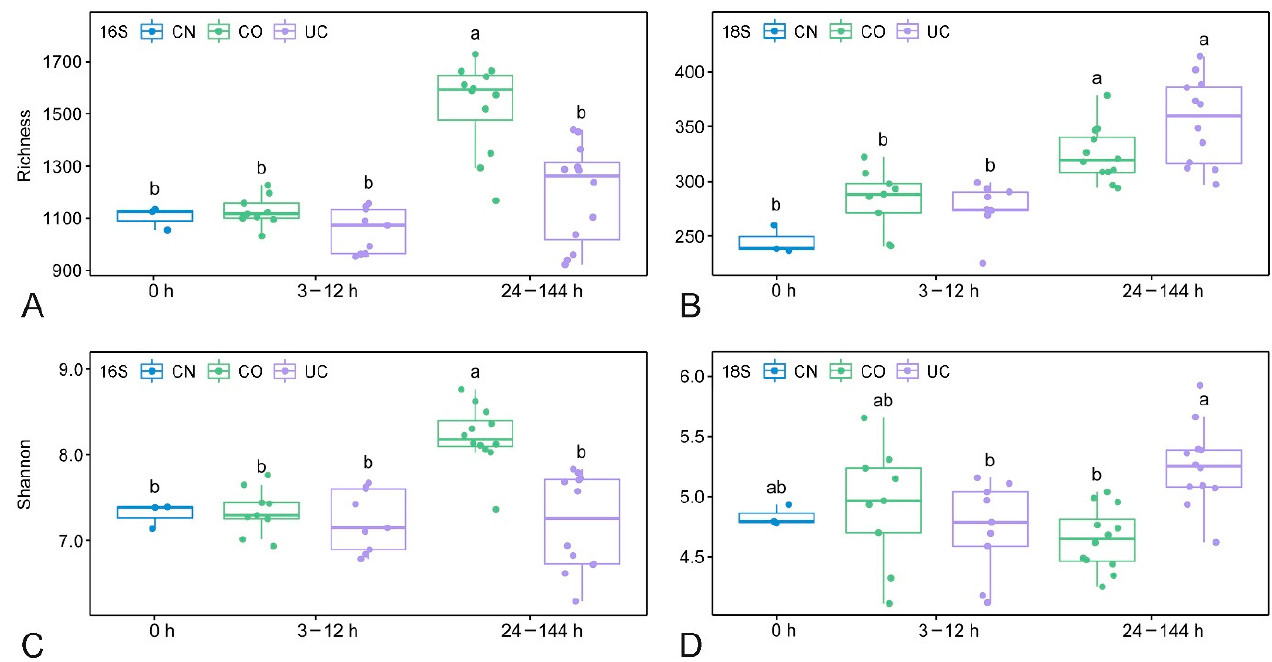
Figure 3. The boxplots showing richness and Shannon index of prokaryotes ( A , C ) and eukaryotes ( B , D ) under different storage conditions. Different letters indicate a statistical significance ( p < 0.05, ANOVA) between different groups. CN: control group, CO: with lid closed, UC: without lid.